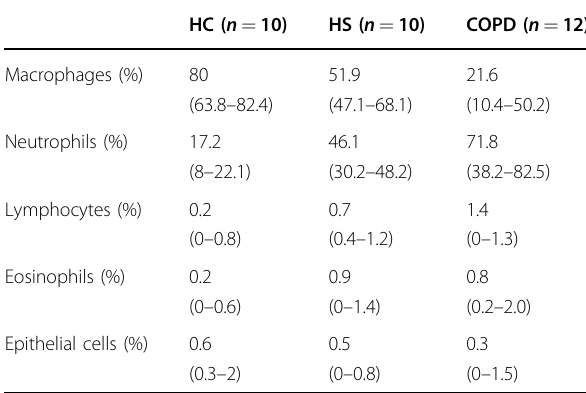
Table 2 Differential cell count of induced sputum